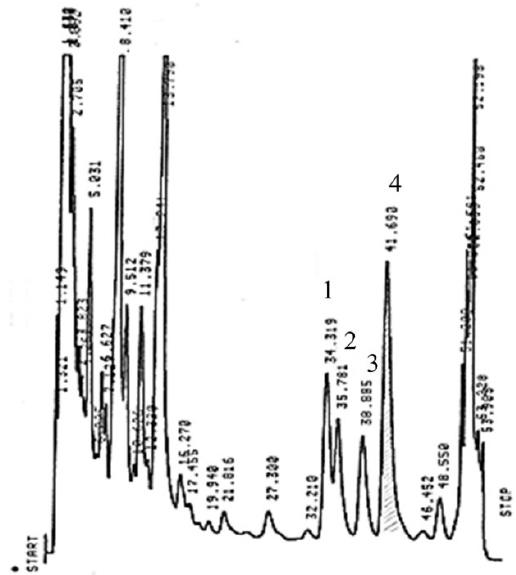
Figure 4. Reverse-phase HPLC of Azorean (Gorreana) tea on a 5 µm Hypersil ODS (100 × 4.6 mm i.d.). A 12.5 µ L sample of the extract was subjected to HPLC analysis. Mobile phase: H 2 O:formic acid